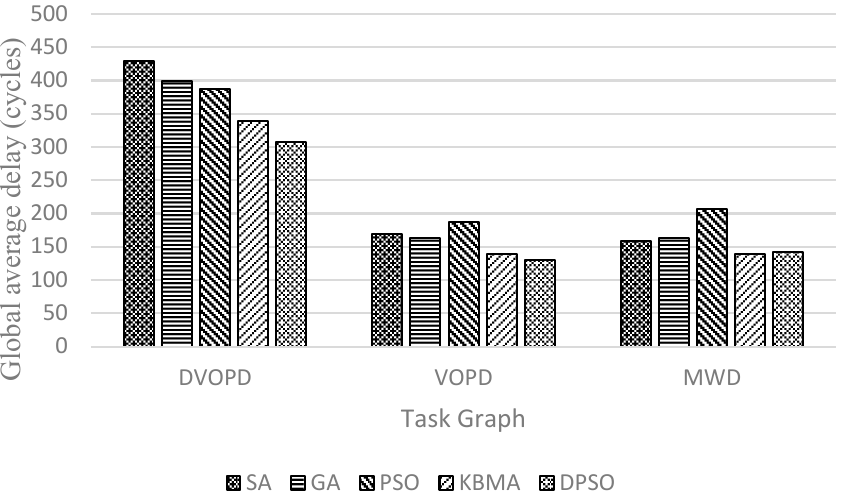
Figure 4. Communication delay at DVOPD, VOPD and MWD on 4 × 4 × 4 3D mesh structure.